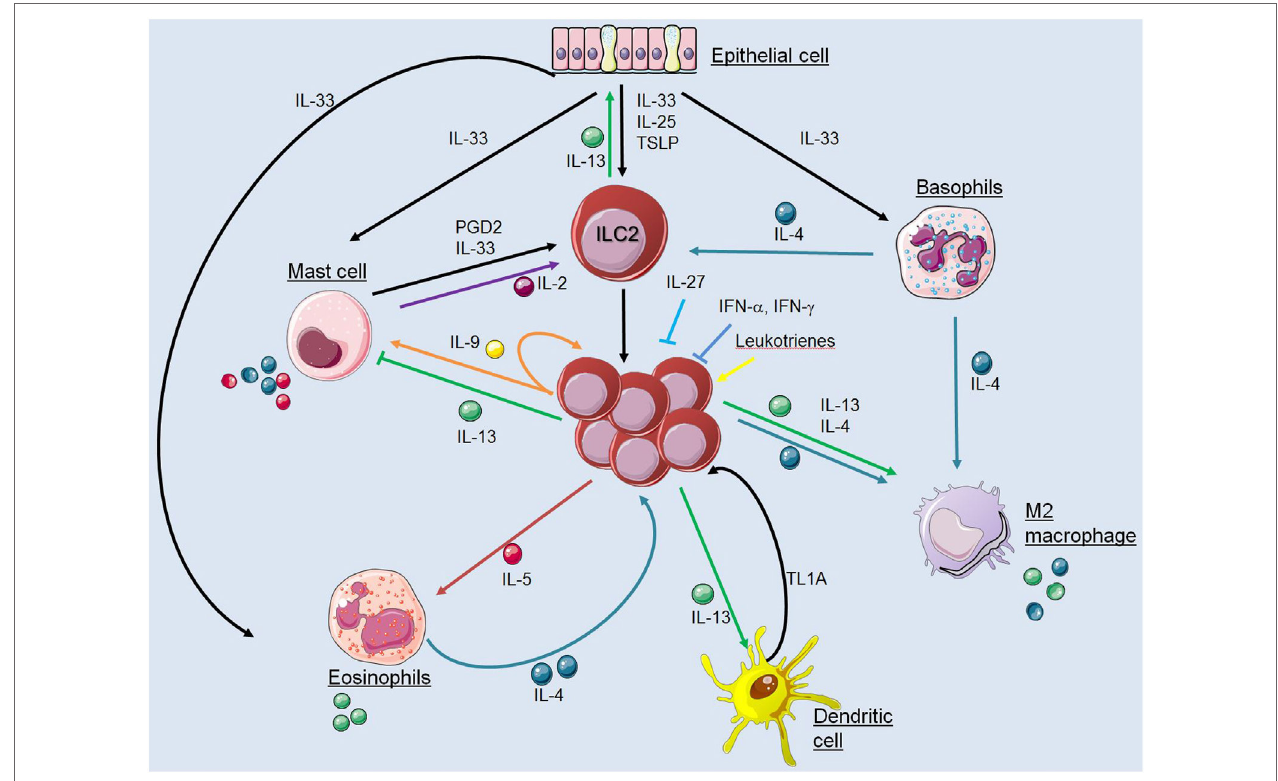
FigURe 2 | Interactions between innate lymphoid cells (ILC2s) and cells of the innate immune system. The figure illustrates communication pathways between ILC2s and other cells of the innate immune system by secretion and recognition of soluble factors as described in the main text. Solid arrows indicate published evidence for activating mechanisms whereas ILC2-derived IL-13 was shown to suppress mast cells and IL-27 or interferons inhibit ILC2 functions. Cell symbols where taken from http://smart.servier.com